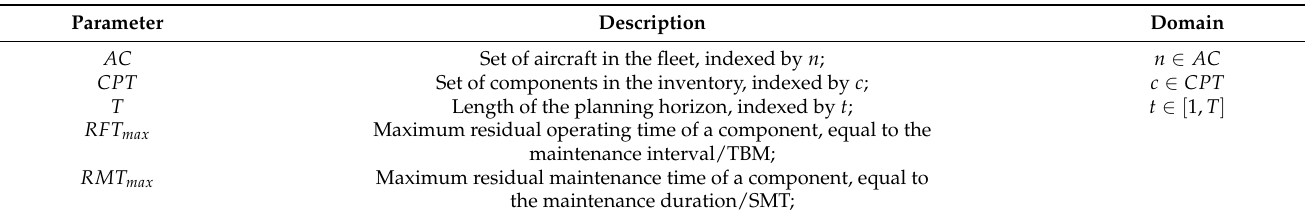
Table A1. CMP optimization model input